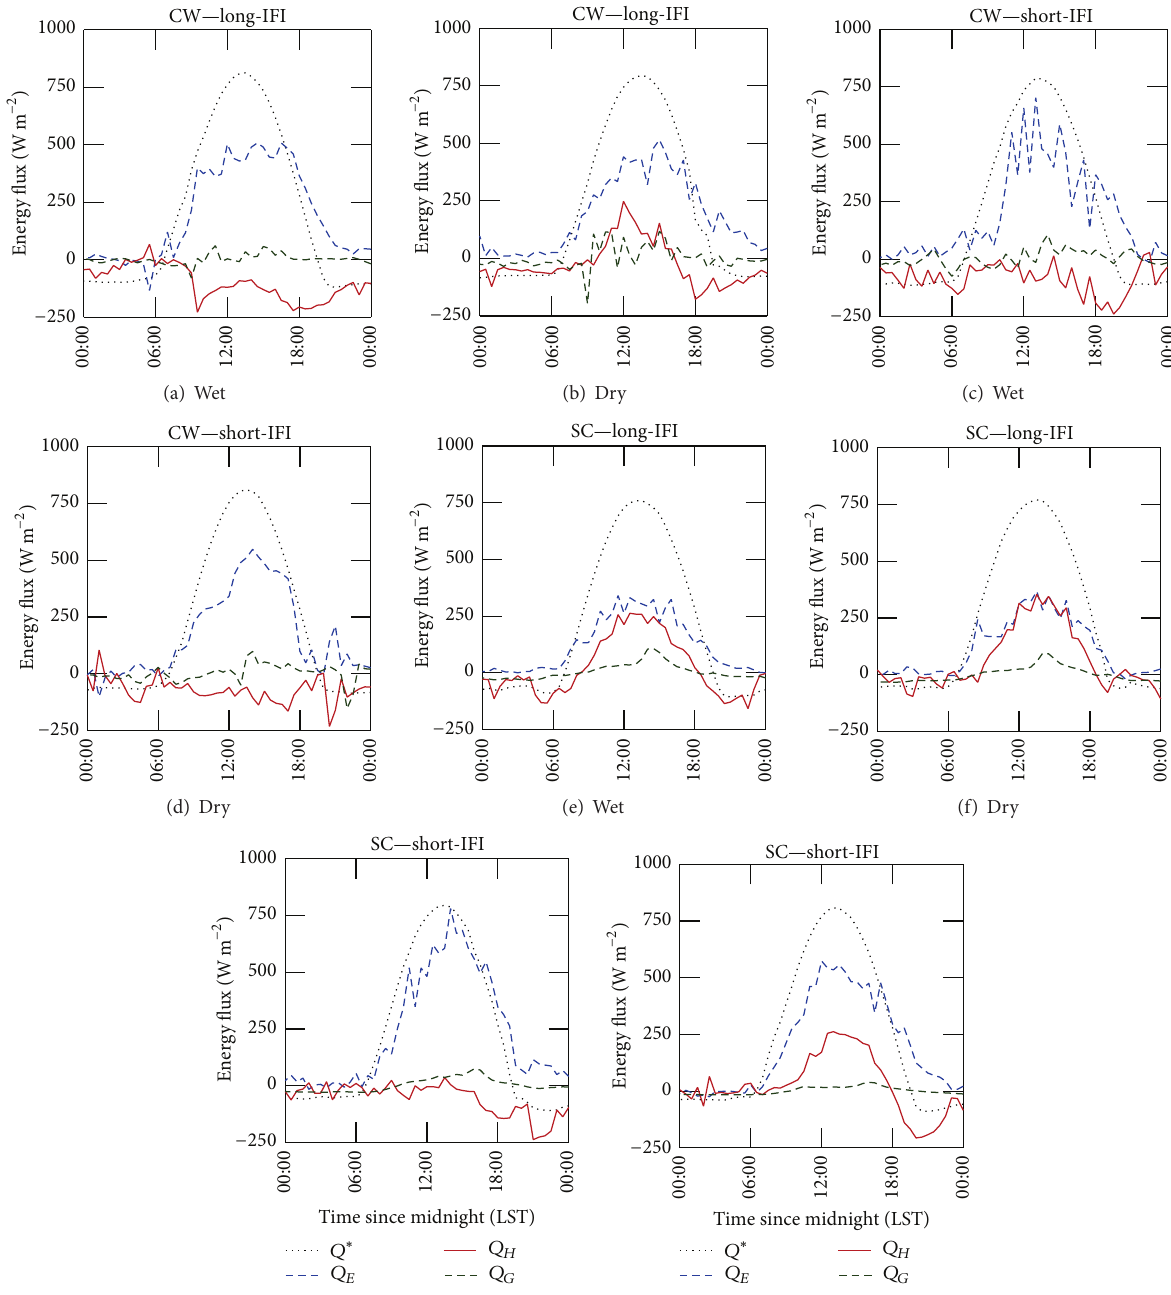
Figure 4: Half-hourly average energy fluxes at the four sites (Table 1) under clear sky conditions and wet versus dry conditions (Table 2). Energy fluxes are net radiation ( 𝑄 ∗ , dotted line), latent heat flux ( 𝑄 𝐸 , blue dashed line), sensible heat flux ( 𝑄 𝐻 , red solid line), and ground heat flux ( 𝑄 𝐺 , green dashed line). CW: cottonwood; SC: saltcedar; IFI: interflood interval.